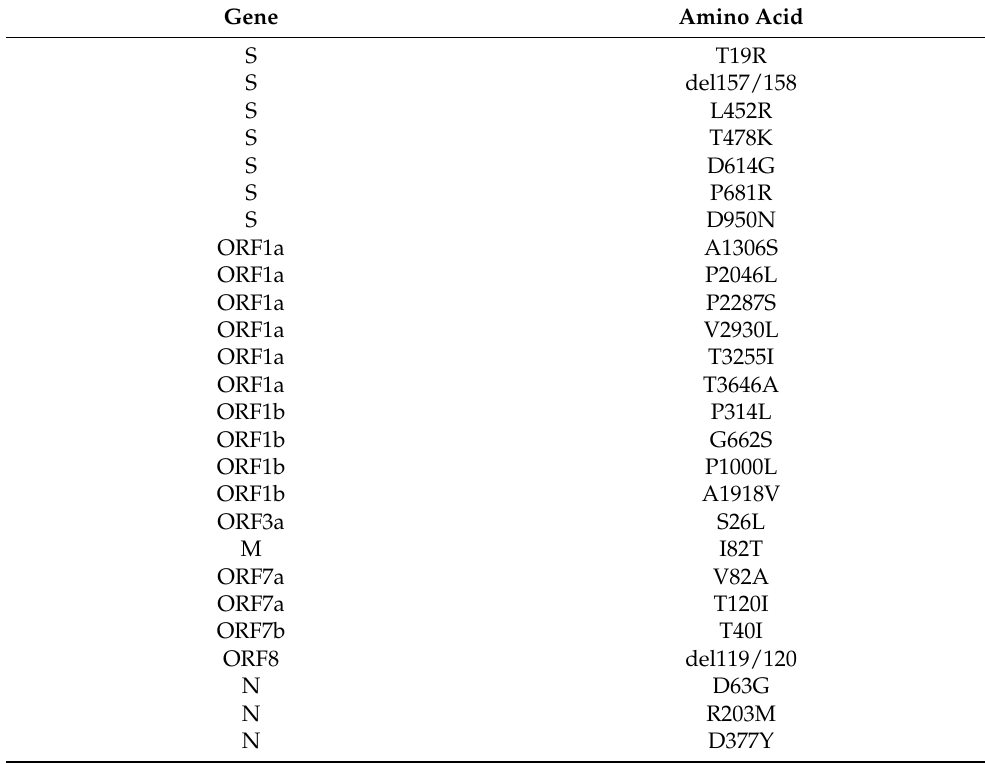
Figure 2. Representation of the spike protein mutations found in the B.1.6172 variant. NTD = N-terminal domain, RBD = receptor-binding domain, RBM = receptor-binding motif, SD1 = subdomain 1, and SD2 = subdomain 2. Table 1. Characteristic mutations of B.1.617.2 [12]. S = spike protein gene, N = nucleocapsid gene, ORF = open reading frames gene, and M = membrane protein